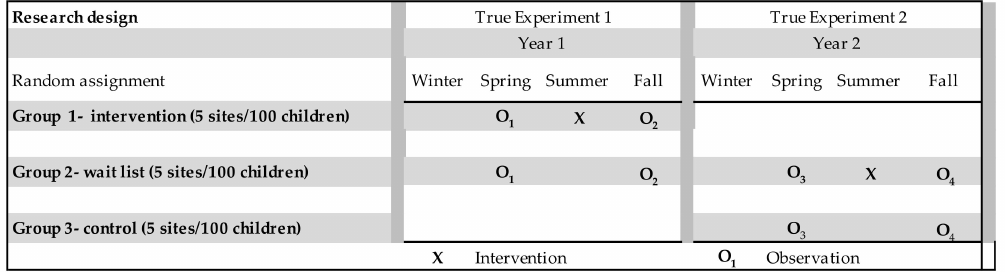
Figure 1. Research design with intervention, waitlist (delayed intervention), and control groups. Note: “fall” data collection was conducted by late summer to avoid attrition of “graduating” five-year-old children.